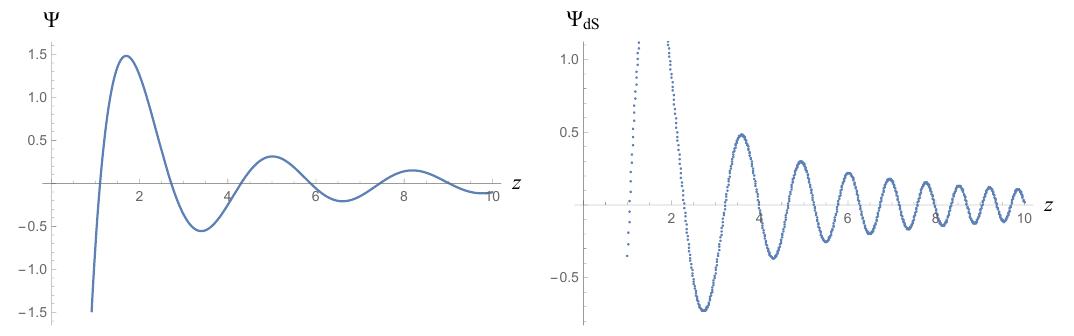
Figure 13 . Left: the genus-zero cosmological ( (cid:0) AdS 2 ) wavefunction for (cid:22) = 1 as a function of the boundary parameter z . Right: the non-perturbative wavefunction exhibiting a faster oscillatory